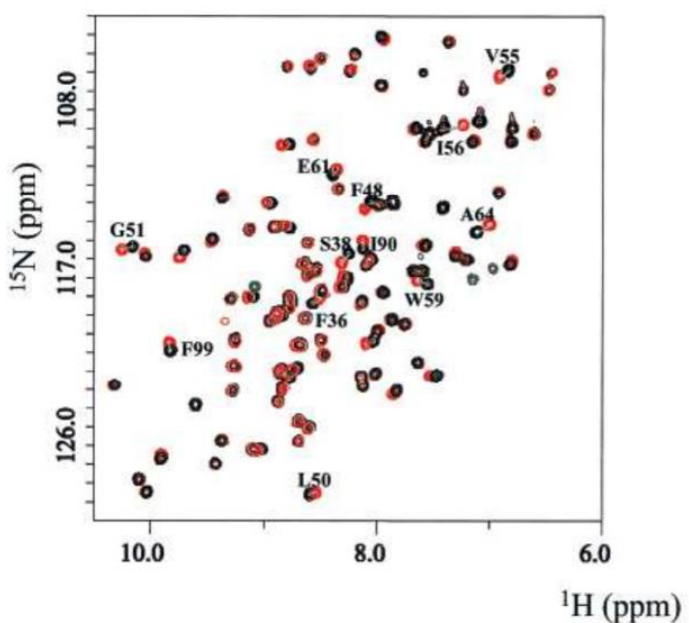
Figure 7. Overlaid 1H-15N-HSQC for FKBP in the absence (black contours) and presence (red contours) of 2-phenylimidazole. Adapted with permission from Hajduk et al. [249].